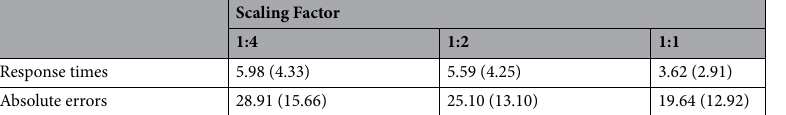
Table 1) and scaling factor (1:1 vs. 1:2 vs. 1:4) as within-participant variables. This ANOVA showed a signifi- cant effect of target locations, F (3.33, 99.84) = 19.35, p < 0.001, η p2 = 0.39, that was best explained by the linear